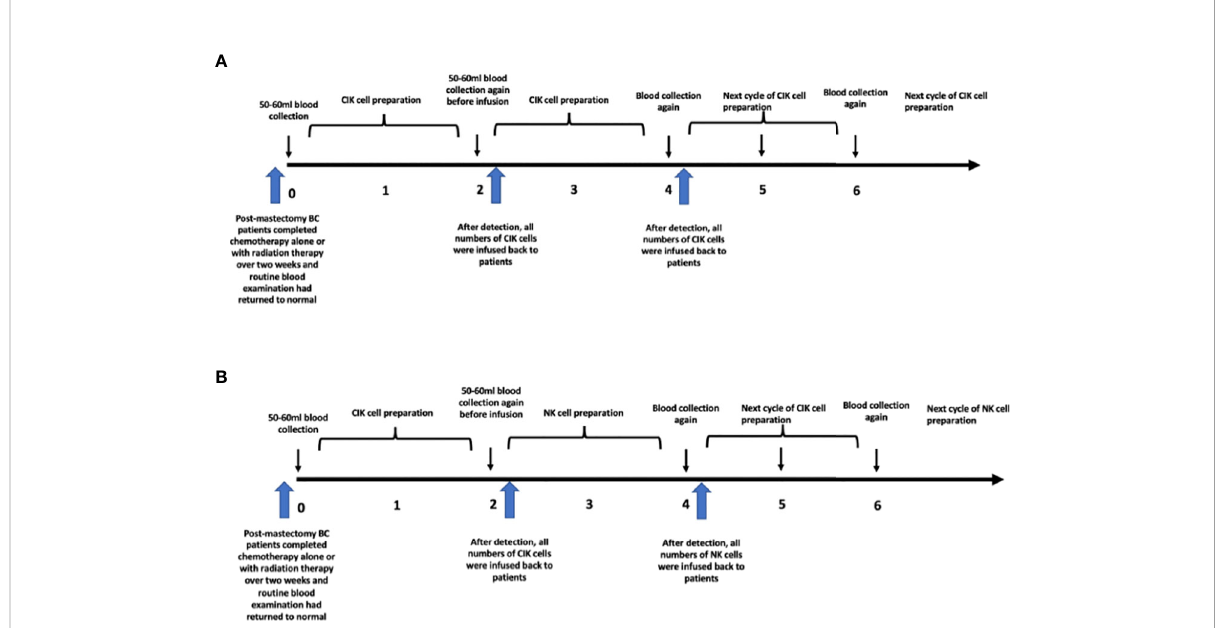
FIGURE 1 Cells cultured process in different groups. (A) CIK group. (B) CIK+NK